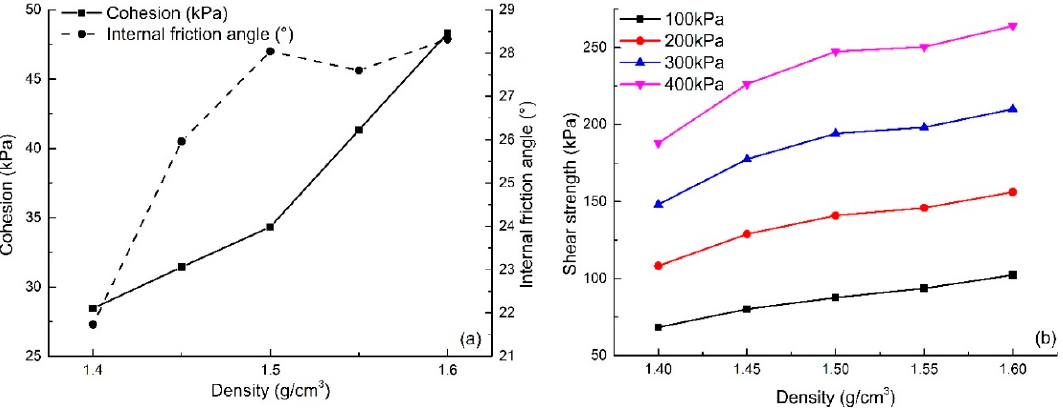
Figure 11. The variation curves with the change of dry density: ( a ) Cohesion and internal friction angle; ( b ) Shear strength.